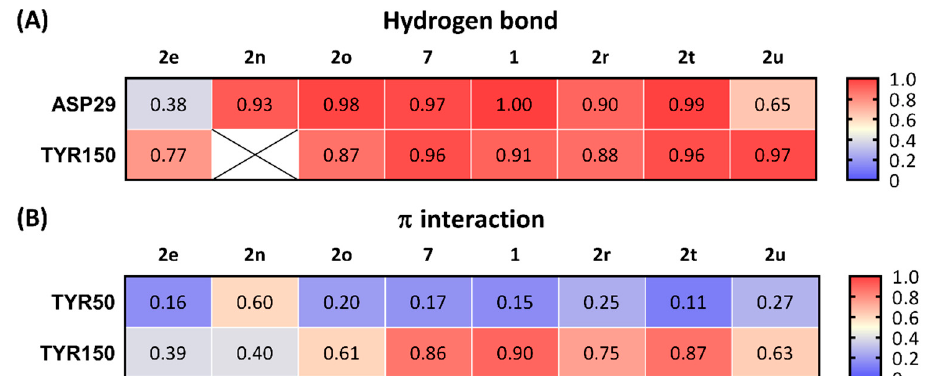
Figure 5. Frequency of contacts for three key interactions between ligands and σ 2R. ( A ) Hydrogen bond and ( B ) π interactions. : No detection of the interactions between ligand and σ 2R.